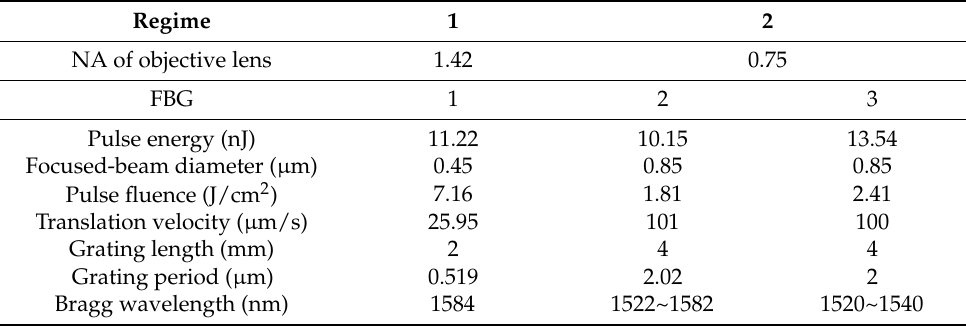
Figure 1. Schematic of the experimental setup for PbP FBG inscription in POP. HWP: half-waveplate, GP: Glan polarizer, CM: collimator, QWP: quarter-waveplate. Table 1. Data of grating inscriptions by the femtosecond laser at 520 nm.